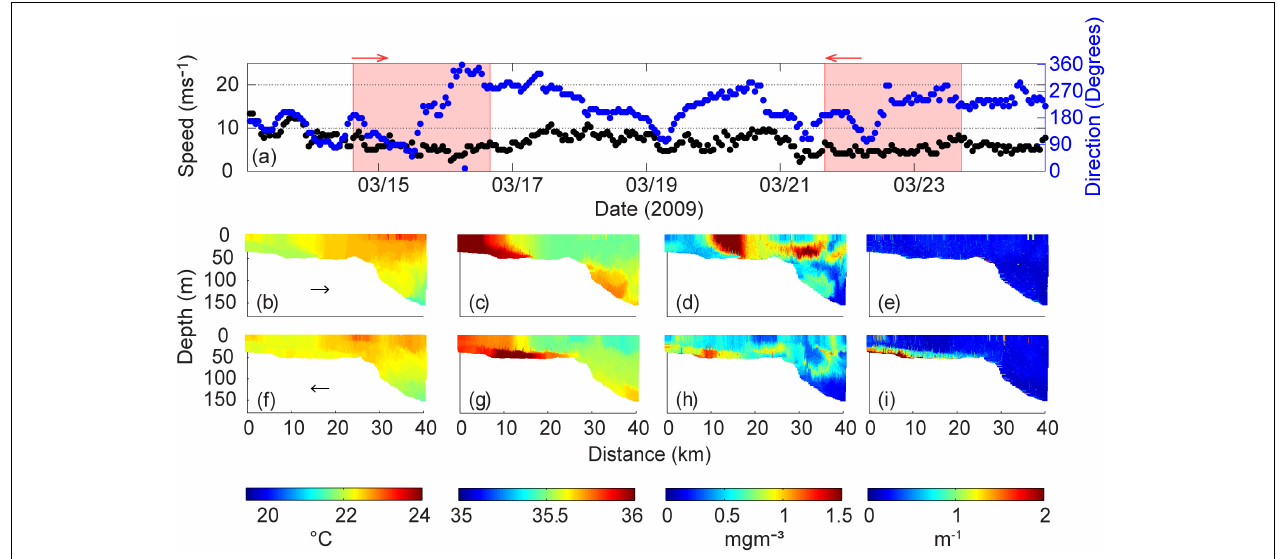
FIGURE 3 | (a) Wind speed and direction at Rottnest Island during 14–23 March 2009. The shaded areas represent the period of ocean glider transect; Ocean glider vertical cross-sections of (b) temperature ( ◦ C); (c) salinity; (d) chlorophyll (mg m − 3 ); and (e) backscatter (m − 1 ) across the Rottnest continental shelf